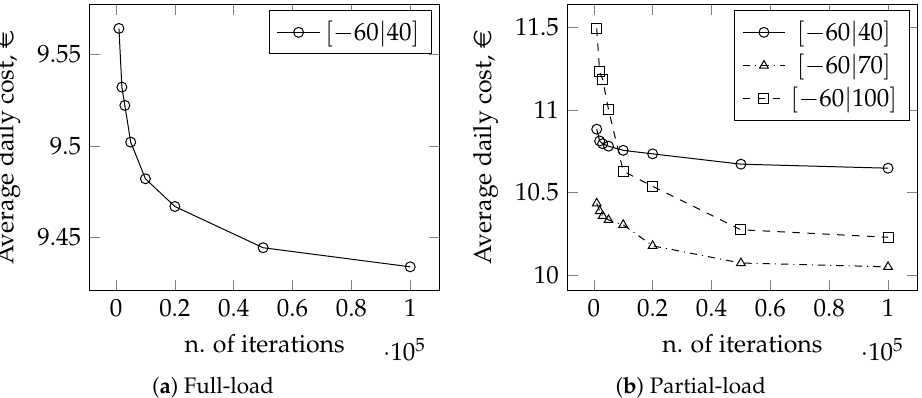
Figure 7. Daily cost for different iterations. Climate Zone 5, multiple family house, 3 families, setting WSB, battery 2 kWh, tank volume 800